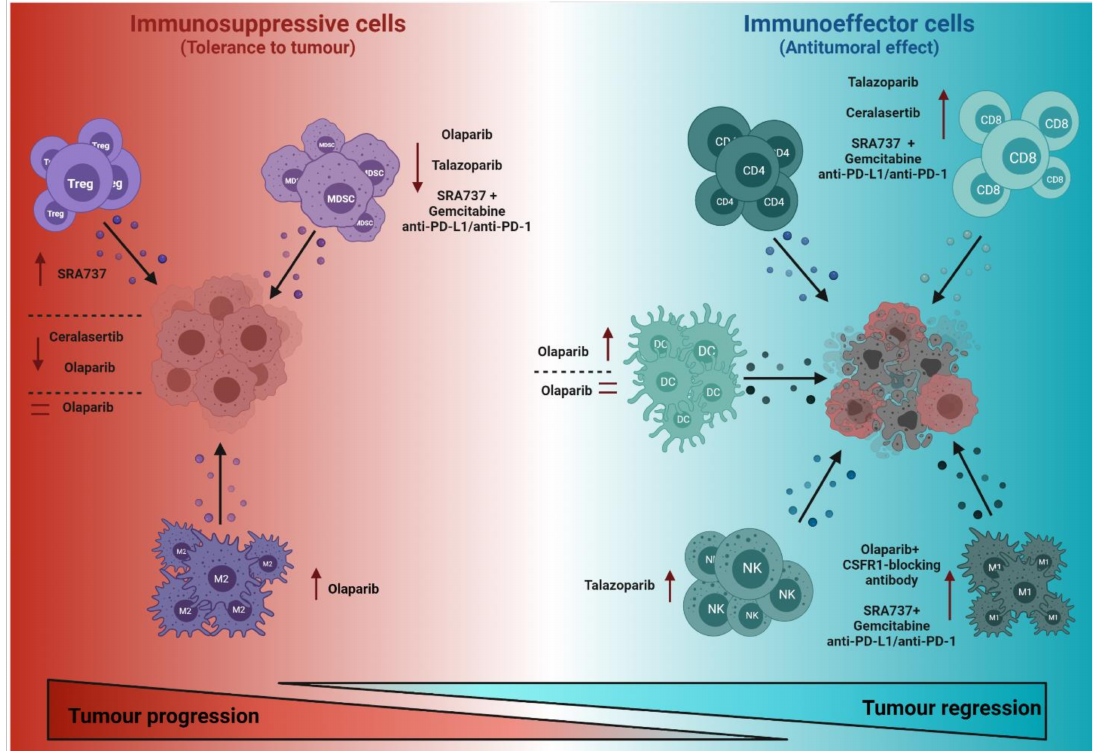
Figure 2. Effects of DDR-targeted agents on the cell components of the immune system. DDR-targeted agents can affect different cells of the immune system, either with immunosuppressive functions (left) or effector functions (right), and thus contribute to promoting or inhibiting tumour progression. CSF1R, colony-stimulating factor 1 receptor; M1, M1 macrophages; M2, M2 macrophages; MDSC, myeloid-derived suppressor cells; NK, natural killer cell; PD-1, programmed death protein-1; PD-L1, programmed death ligand-1; Treg, regulatory T